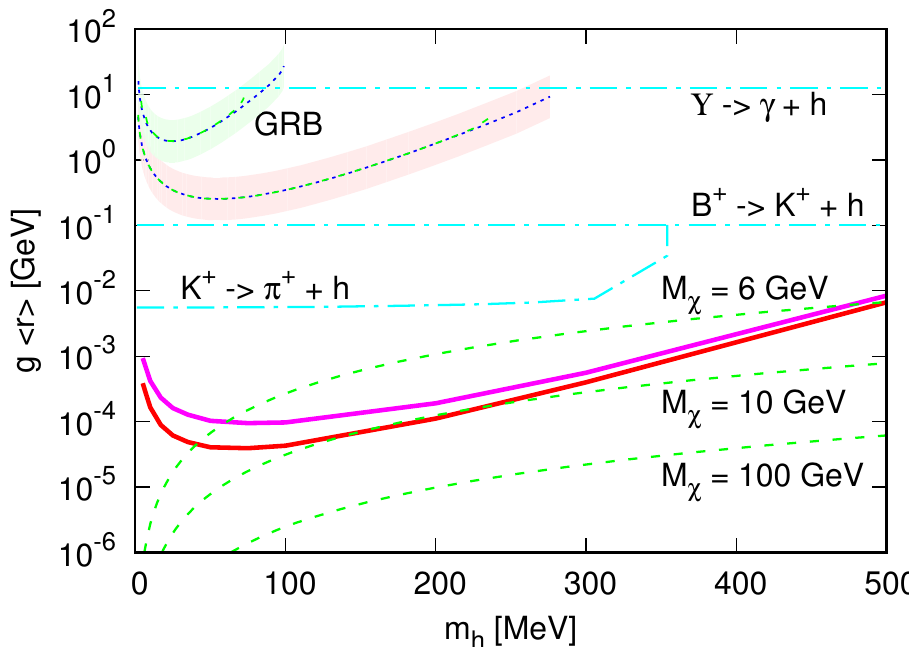
Figure 10 . Same as (cid:12)gure 9, here including the upper limits set by the dark matter direct search experiment LUX, for WIMP mass M (cid:31) = 6, 10 and 100 GeV (dashed lines, from top to